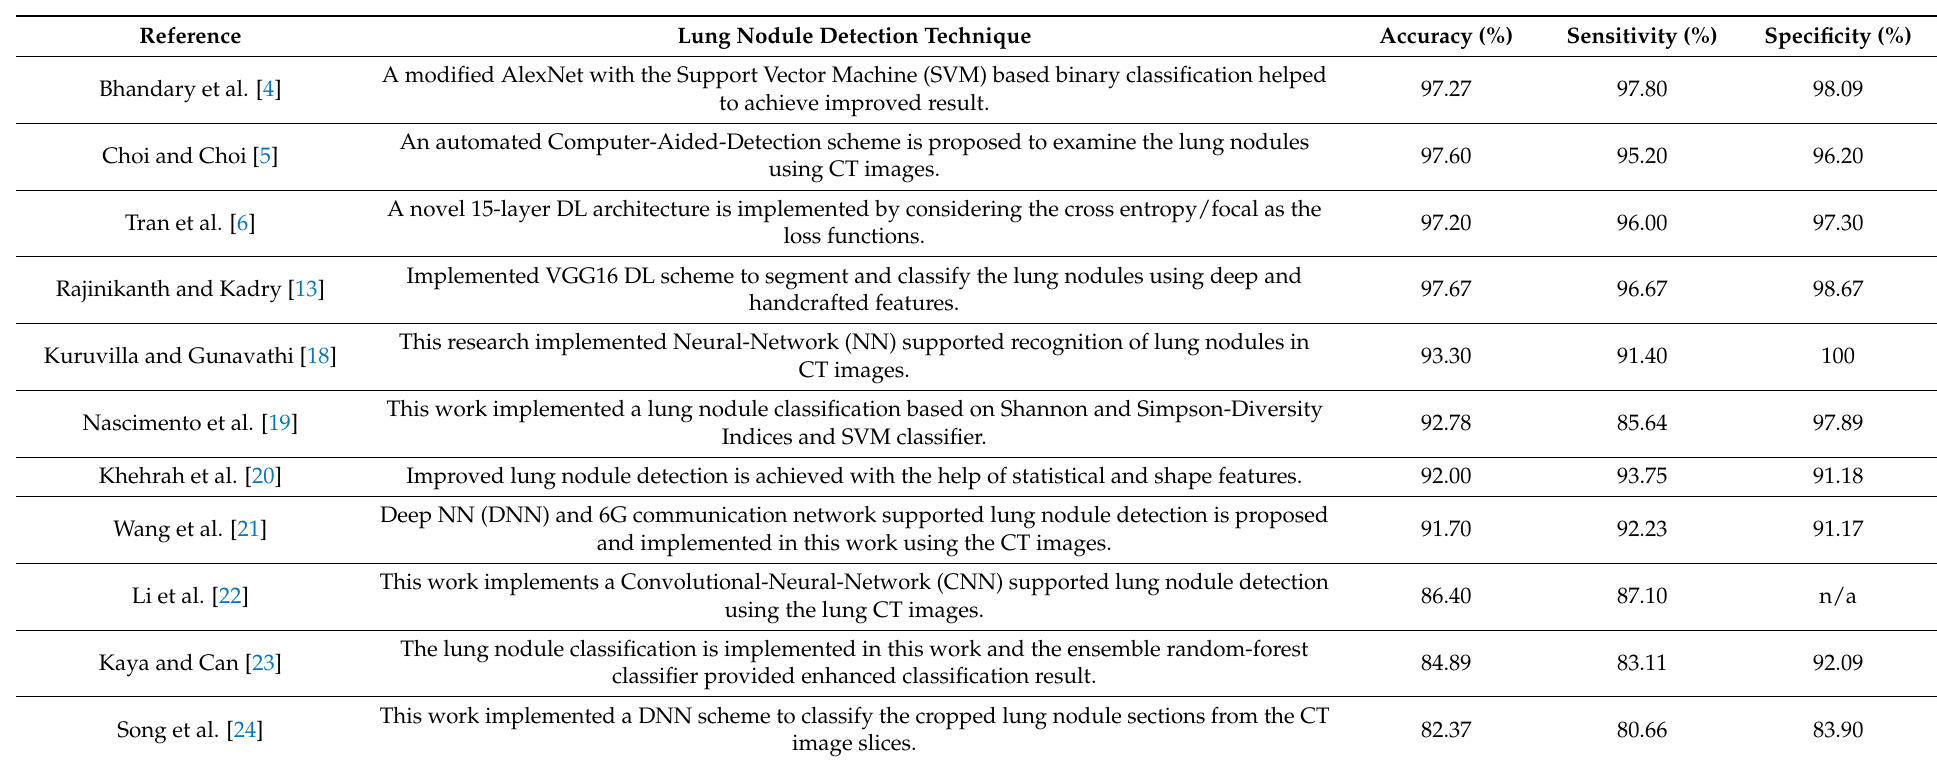
Table 1. Summary of existing lung nodule detection system with LIDC-IDRI